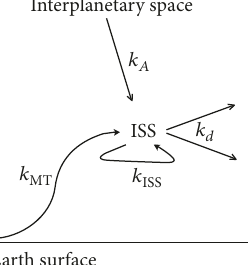
Figure 5: Possible ways of intact DNA (bacterial forms) transfer to the orbit of the ISS and from ISS surface. Kinetic constants of different transfer pathways of microorganisms are indicated as follows: 𝑘 𝐴 : hypothetic Arrhenius’ way from the interplanetary space, 𝑘 mt : possible mass transfer of the dispersed matter from the Earth surface to the ISS orbit with the ascending branch of the global electric circuit, 𝑘 ISS : possible contamination way from ISS internal volume to ISS surface, and 𝑘 𝑑 : dissipation of the dust from the ISS surface to